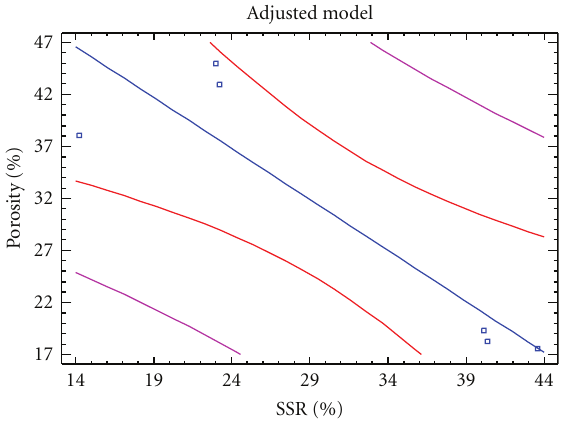
Figure 7: Regression analysis of porosity (%) versus SSR (%).